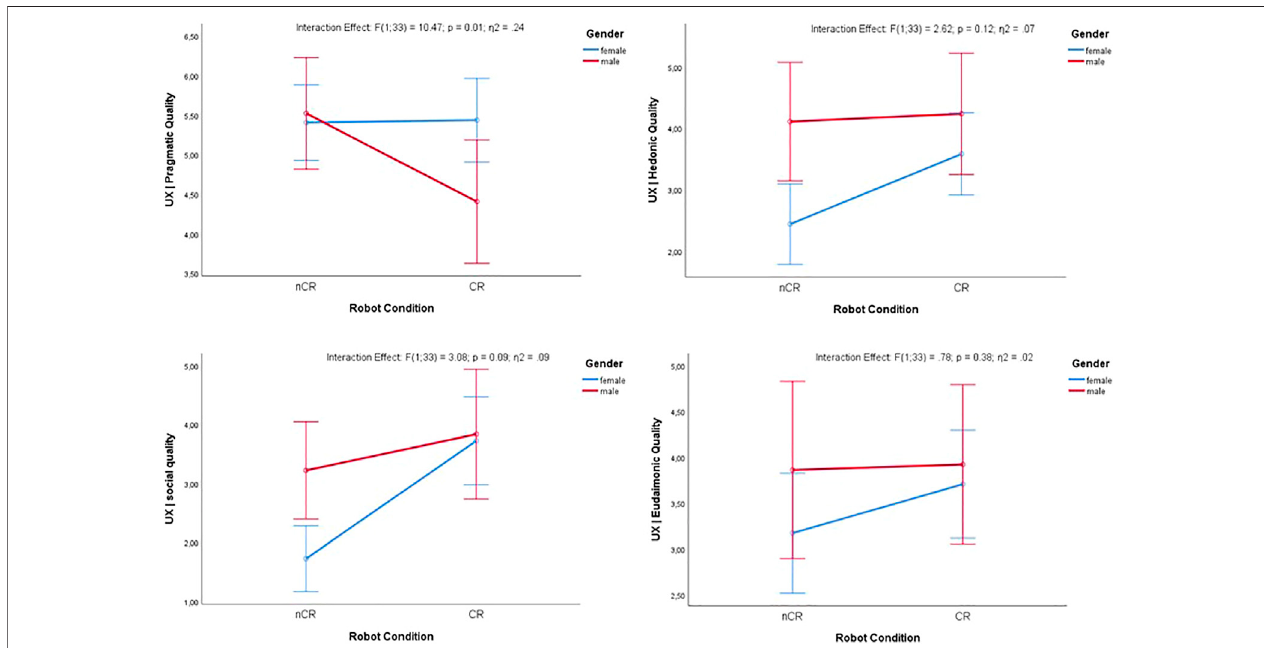
FIGURE 5 | shows the interaction effect between robot condition and gender of participants regarding the UX ratings. nCR refers to the non-conversational robot. CR refers to the conversational robot. The results demonstrate that men decreased the pragmatic rating for the conversational robot compared to the non- conversational robot. In contrast, women increased their hedonic, social, and eudaimic rating for the conversational robot (by trend).